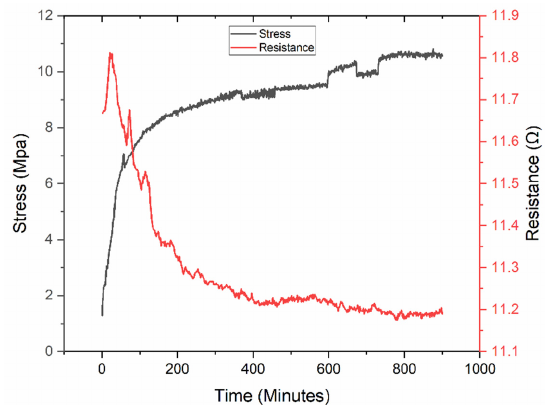
Figure 11. Wet contraction test for strain (black, left) and resistance (red, right). Strain increases significantly due to the removal of water and polymer stiffening, while electrical resistance remains fairly constant.